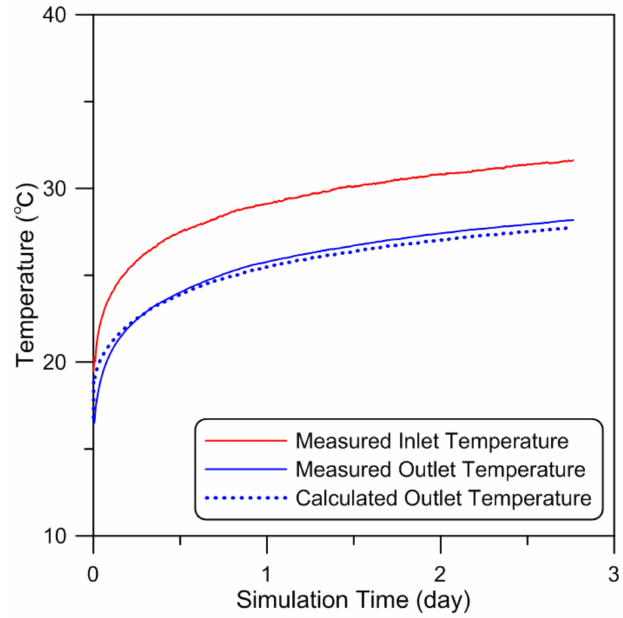
Figure 6. Comparison of measured outlet temperature with calculated